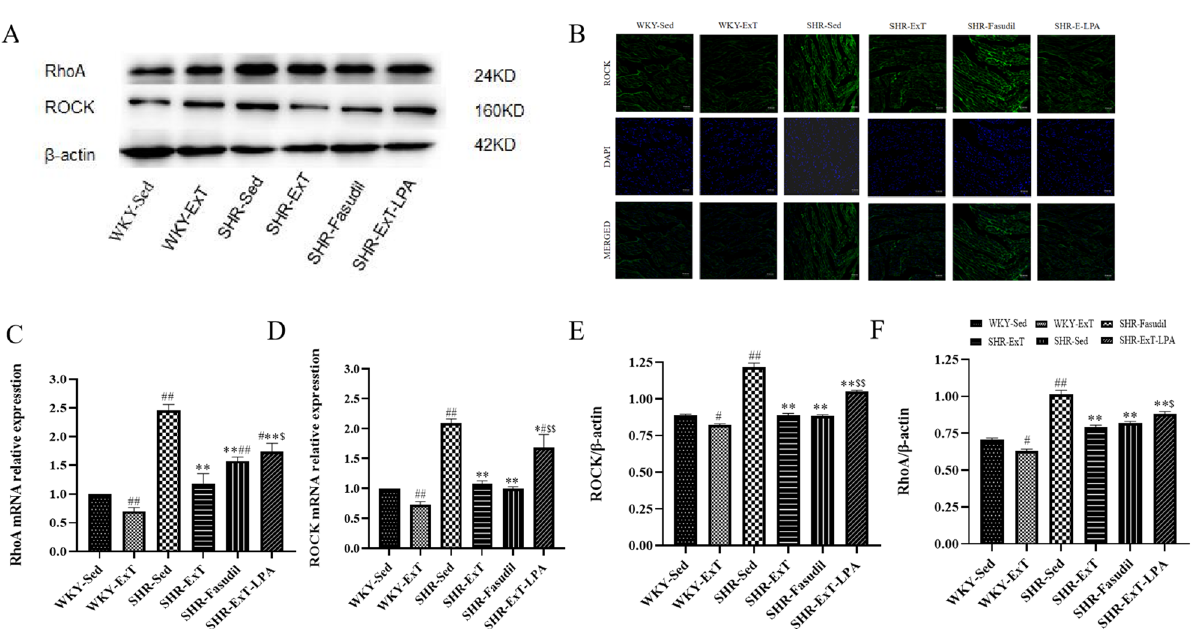
Figure 6. Effect of exercise training on expression of RhoA and ROCK. ( A ) Representative blot images of RhoA and ROCK proteins. ( C,D ) Expression of RhoA and ROCK mRNA. ( E,F ) Expression of RhoA and ROCK proteins. SHR-Sed SHR control group, WKY-Sed WKY control group, SHR-ExT SHR exercise group, WKY-ExT WKY exercise group, SHR-ExT-LPA SHR exercise plus LPA group; SHR-Fasudil SHR plus Fasudil group; data are expressed as mean ± SEM. n = 3 in each group. # P < 0.05, ## P < 0.01 vs WKY-Sed; $ P < 0.05, $$ P < 0.01 vs SHR- ExT; * P < 0.05, ** P < 0.01 vs SHR-Sed. ( B ) Representative confocal photomicrographs of ROCK-stained and DAPI-stained left ventricular sections. Green fluorescence shows ROCK-positive cells; blue fluorescence shows the nuclei of cardiomyocytes (DAPI-positive). Scale bar = 50